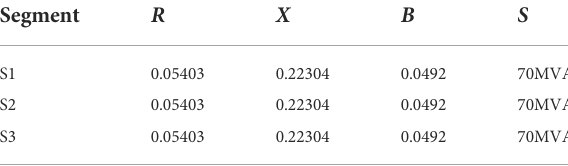
TABLE 6 Parameters of the AC transmission line